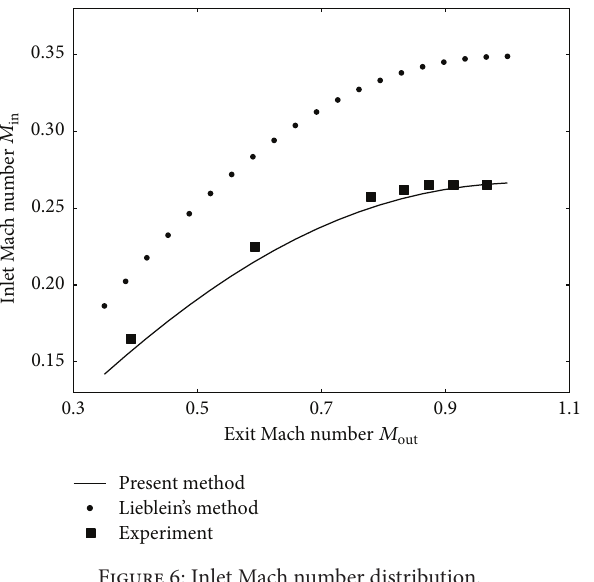
Figure 8: Blade surface Mach number